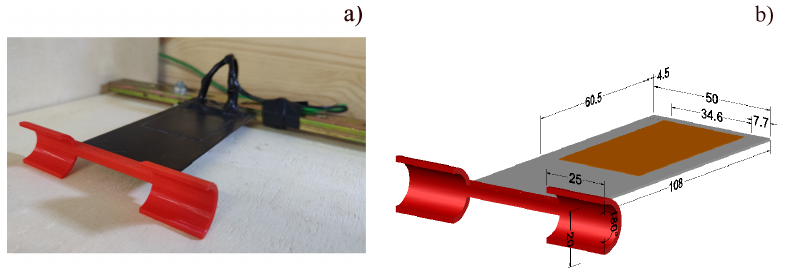
Figure 1. Picture of the experimental FEH ( a ); the red VI in the foreground is mounted on the tip of the beam, the latter being coated with black paint. Sketch of the FEH ( b ); all dimensions are in